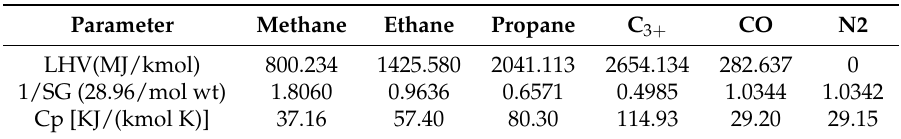
Table 2. Component quality parameters.